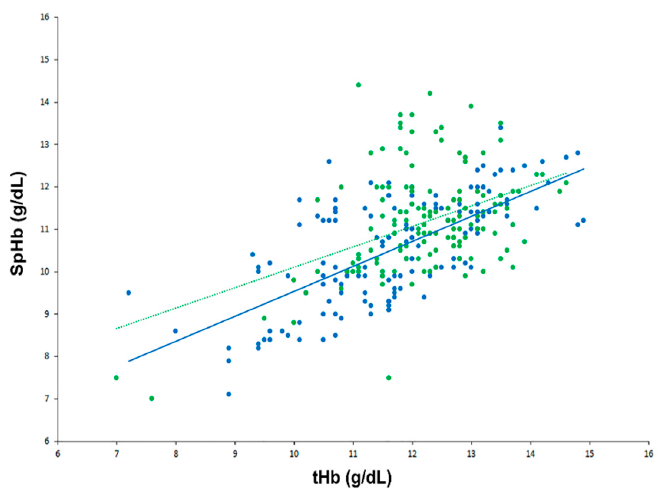
Figure 2. Scatter plot showing real-time continuous hemoglobin and laboratory hemoglobin data in the low carbon dioxide (CO 2 ) (blue) and high CO 2 groups (green).